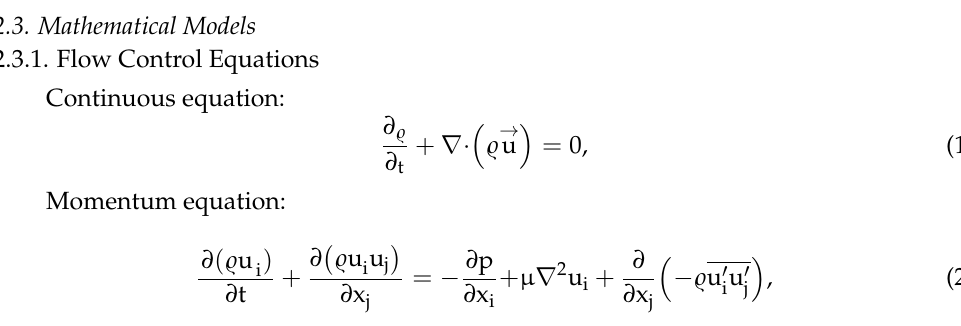
Figure 3. The grid model of the experimental kitchen: ( a ) Partial surface grid in the kitchen; ( b ) Body grid of the air domain in the kitchen.